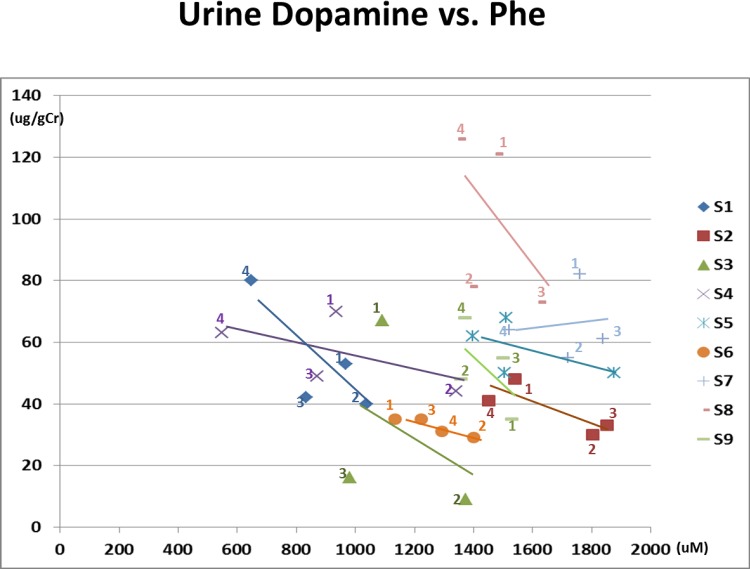
Urine dopamine vs. Plasma phenylalanine.The number of each data point indicates the study phase. Negative correlations with plasma phenylalanine concentrations and urine dopamine (p = 0.047) are shown. Except for S7, a linear negative regression line is drawn for each subject.